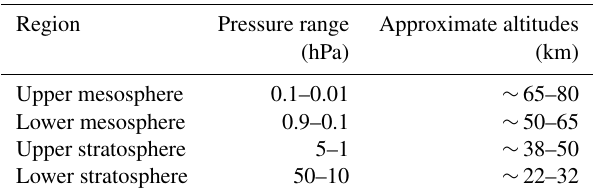
Table 4. Definition of the pressure ranges and corresponding alti- tudes used in this